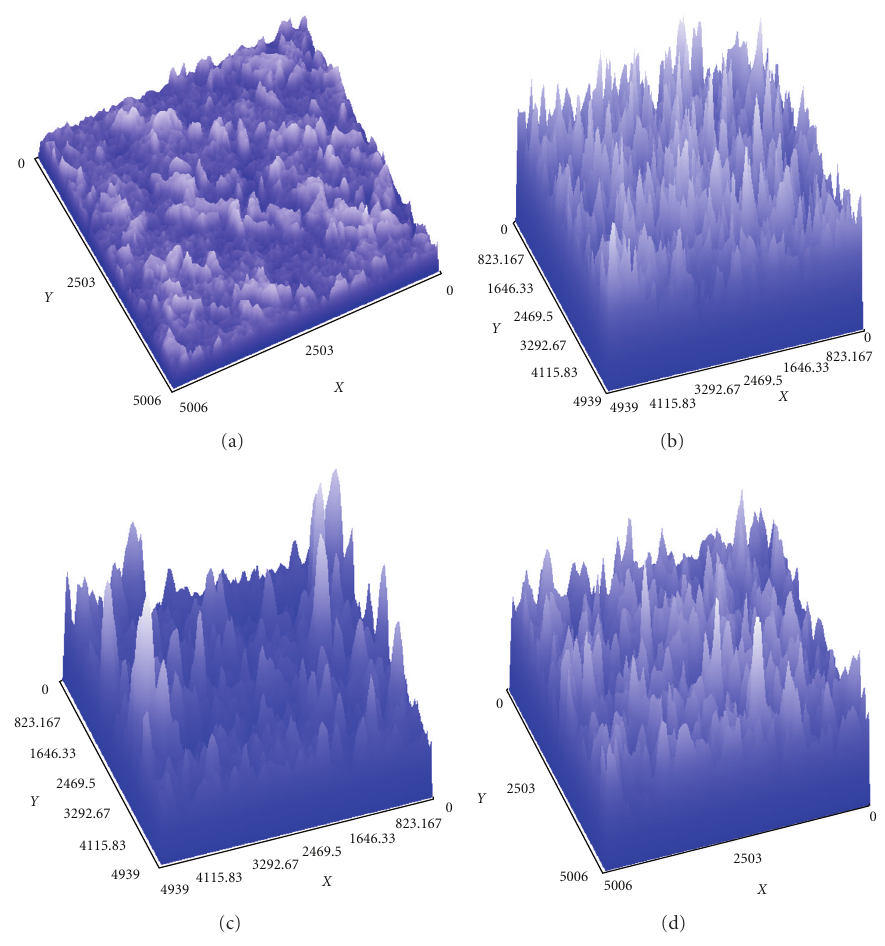
Figure 5: AFM 3D images: (a) uncoated quartz glass, (b) SiO 2 , (c) ST 3, and (d) ST 5 thin film coated on quartz glass.